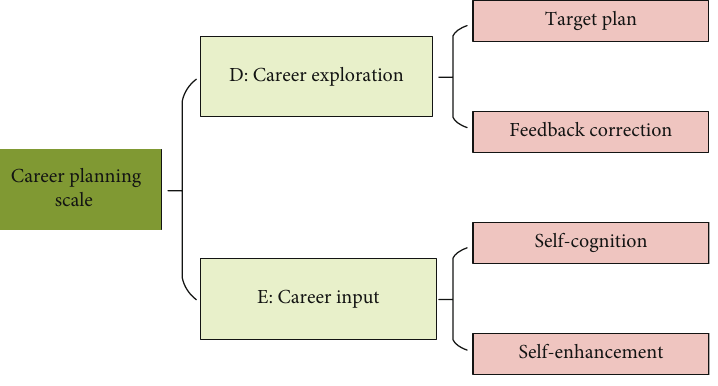
Figure 4: Career planning scale.